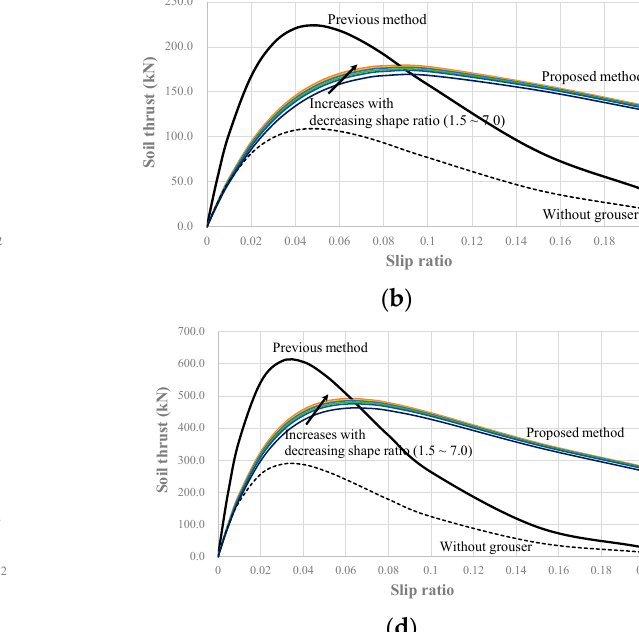
Figure 11. Soil thrust and slip displacement curves in soils exhibiting a hump behavior ( c = 2.3 kPa, φ = 54.9 ◦ , K h = 14.4): EC145E with a grouser height of ( a ) 25 mm ( b ) 50 mm ( c ) 70 mm ( d ) EC380E with 70 mm grouser height.